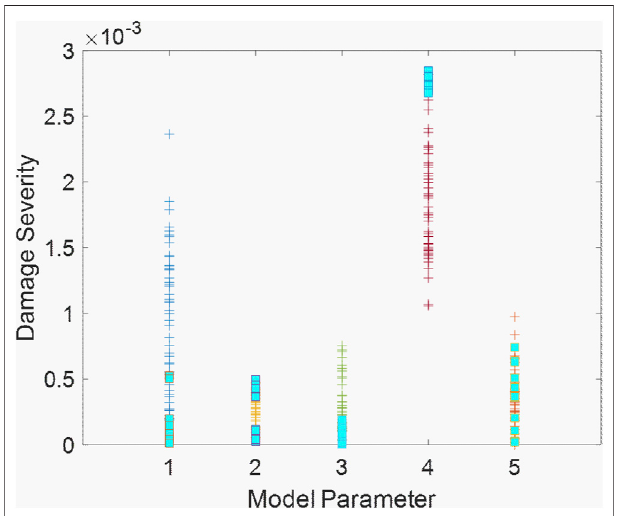
FIGURE 5 | Solutions identi fi ed in the probabilistic Pareto optimal set (squared markers indicate the deterministic Pareto optimal set).